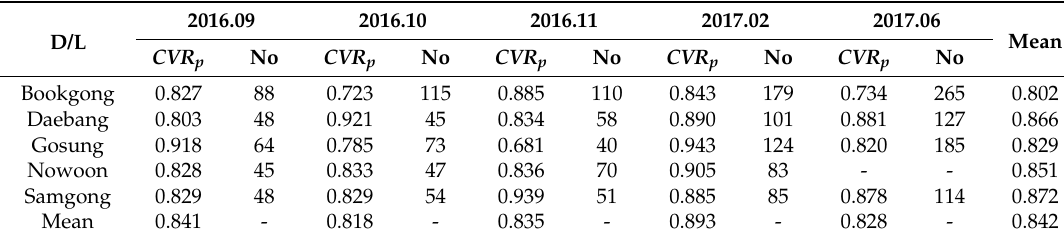
Table 3. CVR factors for the active power of the Chimsan substation (direct method).